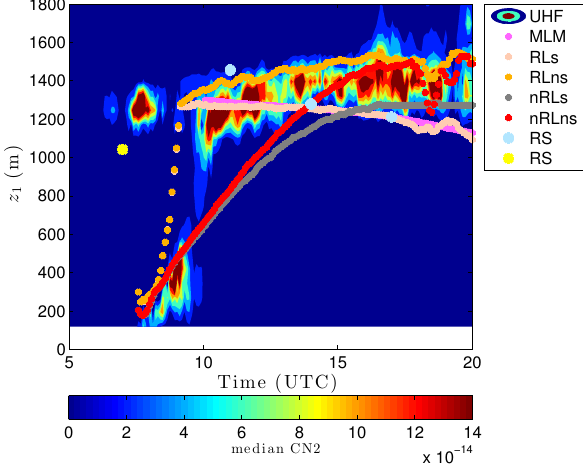
Fig.4. Temporalevolutionofpotentialtemperatureon1July2011observedbydifferentinstrumentsat2m(symbols)andobtained(lines) Fig. 5. Temporal evolution during 1 July 2011 of the refractive structure coefficient measured by UHF wind profiler (color contour), and Fig. 4. Temporal evolution of potential temperature on 1 July 2011 Fig. 5. Temporal evolution during 1 July 2011 of the refractive byMLMwithsubsidence(red)andDALES(RLs,solidblue;RLns,dashblue;nRLs,solidgreen;andnRLns,dashgreen). Observationsare boundarylayerdepthestimatedfromradiosoundings(lightbluedots),andobtainedbyMLM(magentaline),andDALESruns(RLs,pink; observed by different instruments at 2m (symbols) and obtained from EC instrument at the tower over grass (TOW, cyan circles), over short grass (G, magenta diamonds), over the edge between the long RLns,orange;nRLs,grey;andnRLns,redlines). Yellowdotrepresentstheresiduallayerdepthestimatedfromaradiosounding. structure coefficient measured by UHF wind profiler (color con- grassandthewheat(G–W,orangedots),overlonggrass(LG,blacksquares)andoverwheat(W,redtriangles). (lines) by MLM with subsidence (red) and DALES (RLs, solid blue; tour), and boundary layer depth estimated from radio soundings RLns, dash blue; nRLs, solid green; and nRLns, dash green). Obser- (light blue dots), and obtained by MLM (magenta line), and DALES vations are from EC instrument at the tower over grass (TOW, cyan runs (RLs, pink; RLns, orange; nRLs, grey; and nRLns, red lines). circles), over short grass (G, magenta diamonds), over the edge be- Yellow dot represents the residual layer depth estimated from a ra- tween the long grass and the wheat (G–W, orange dots), over long dio grass (LG, black squares) and over wheat (W, red triangles).